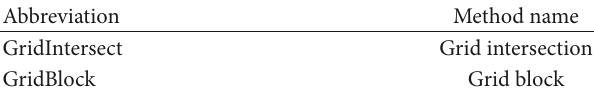
Table 2: Abbreviations for OF extraction